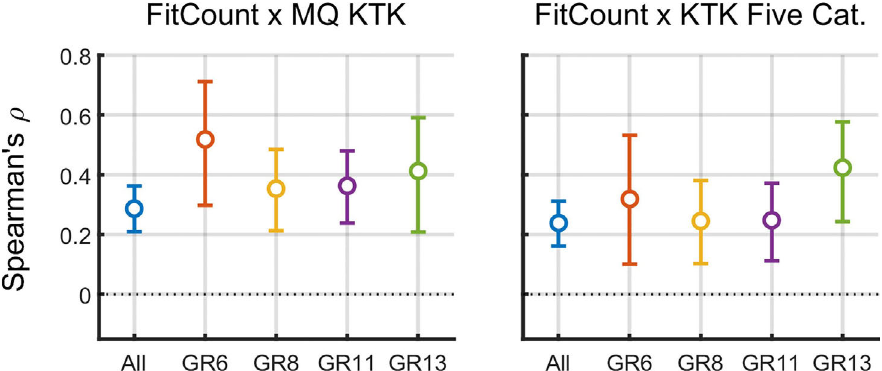
Figure 2 - Correlations (Spearman's ρ ) between the sum of tests achieving fit status on the Fitnessgram (FitCount) and the standardized measures of KTK (motor quotient (cid:0) MQ, and categories derived from MQ) for all ages (not controlling for age and sex) and for each age group (partial correlation con- trolled by sex). The circle represents the mean and the error bars of the 95% confidence interval of the bootstrap distribution after